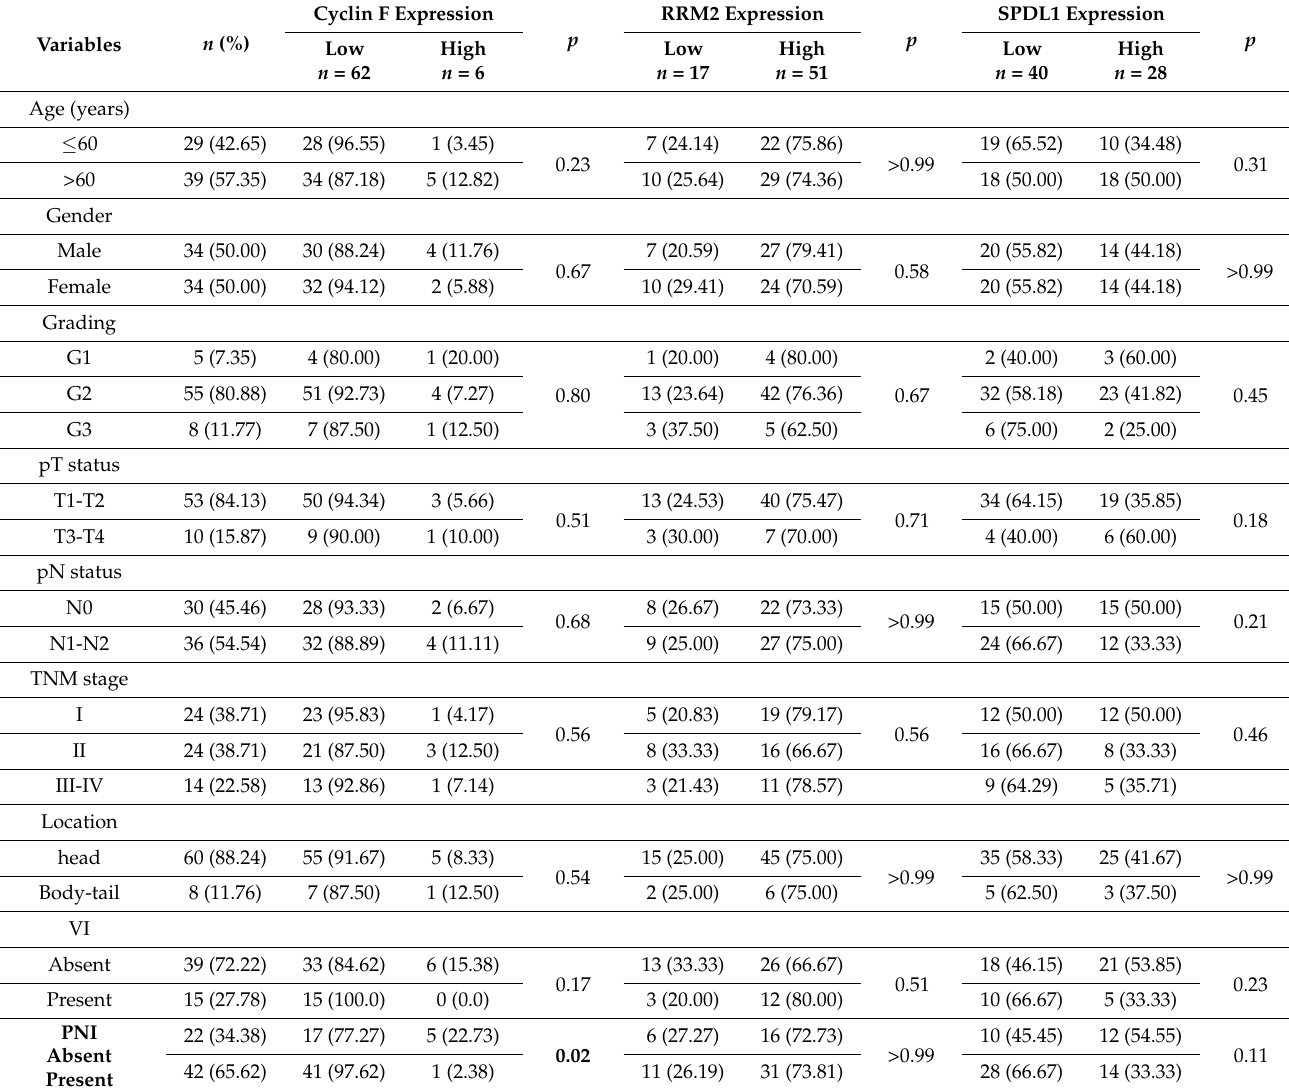
Table 1. Association of cyclin F, RRM2, SPDL1, and the clinicopathological features in our cohort of PDAC patients ( n = 68).